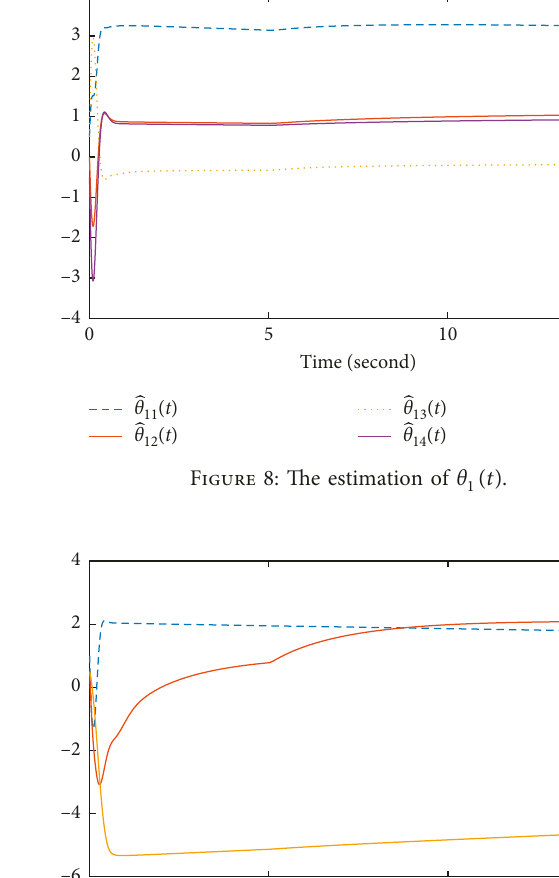
, d ∗ ,d ∗ , and d ∗ 1 2 3